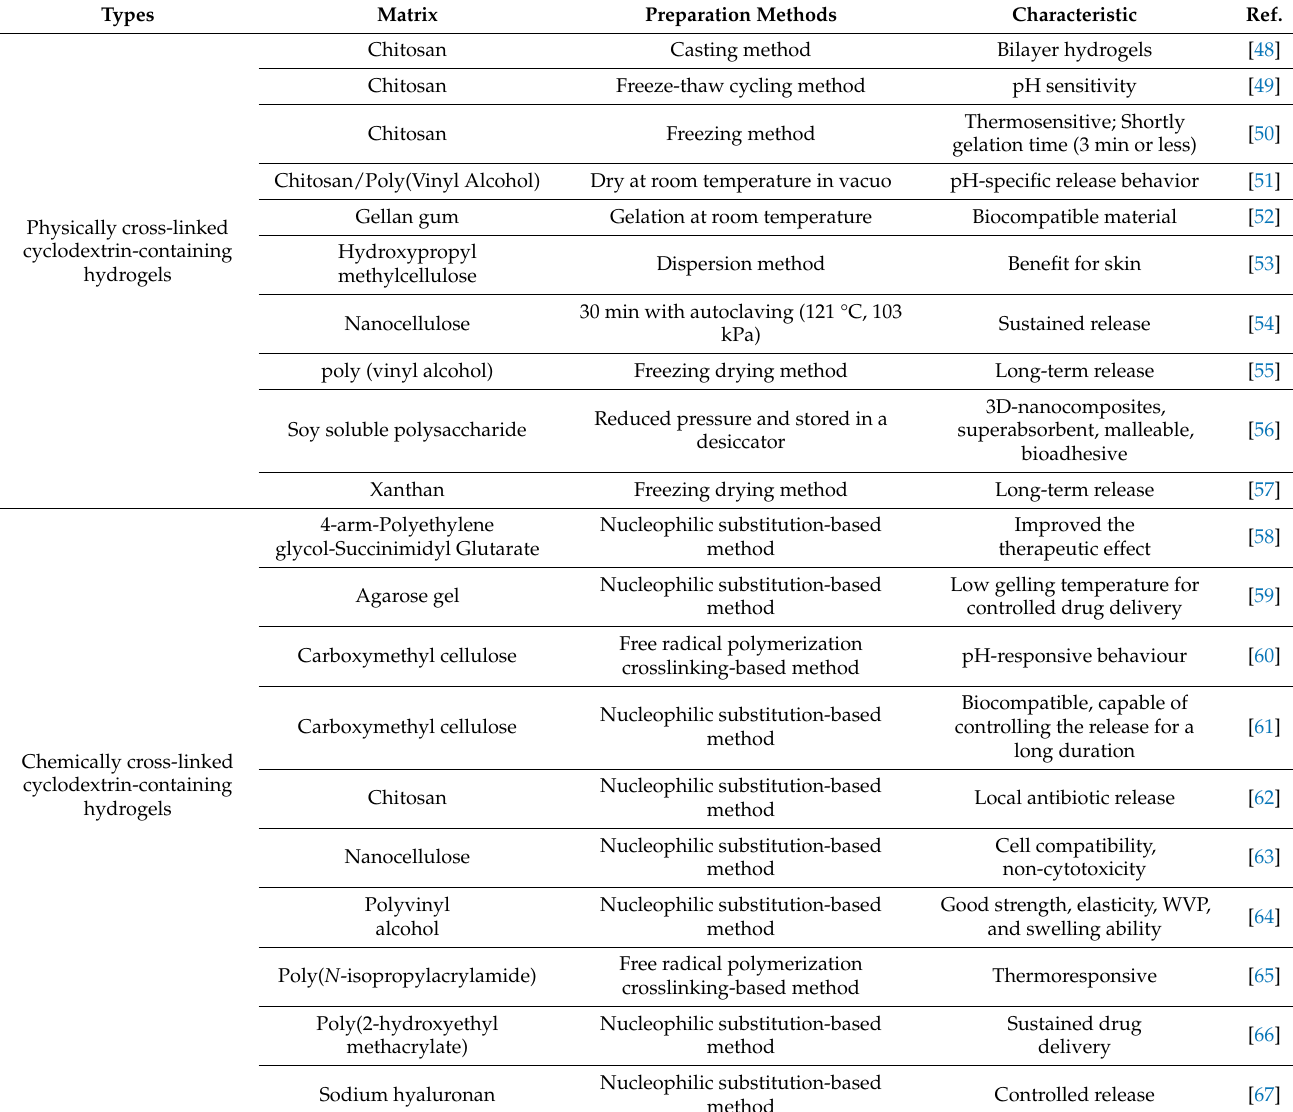
Table 2. The preparation methods of cyclodextrin-containing